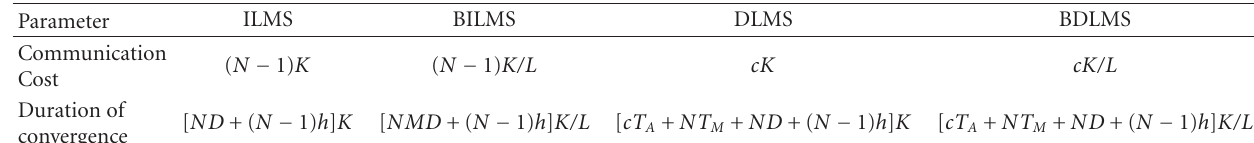
Table 1: Comparison of performances of distributed algorithms and block distributed algorithms.